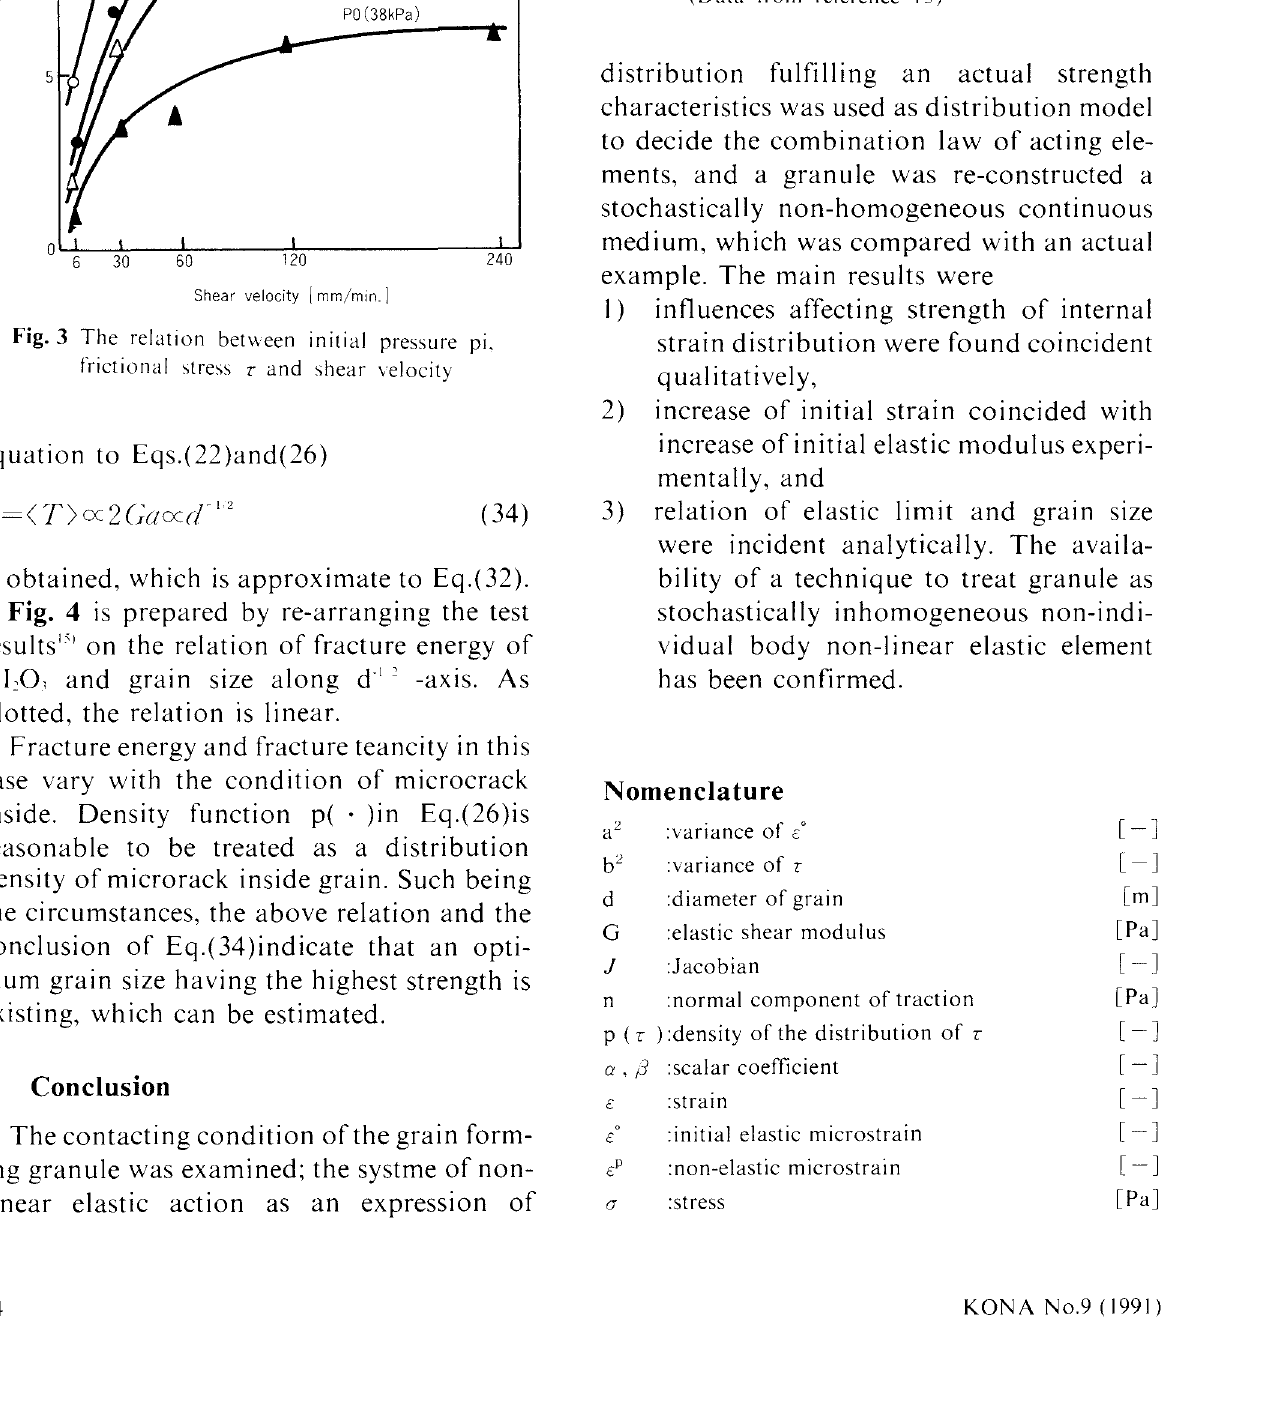
Fig. 4 Dependence of fracture energy on grain size (Data from reference 15)